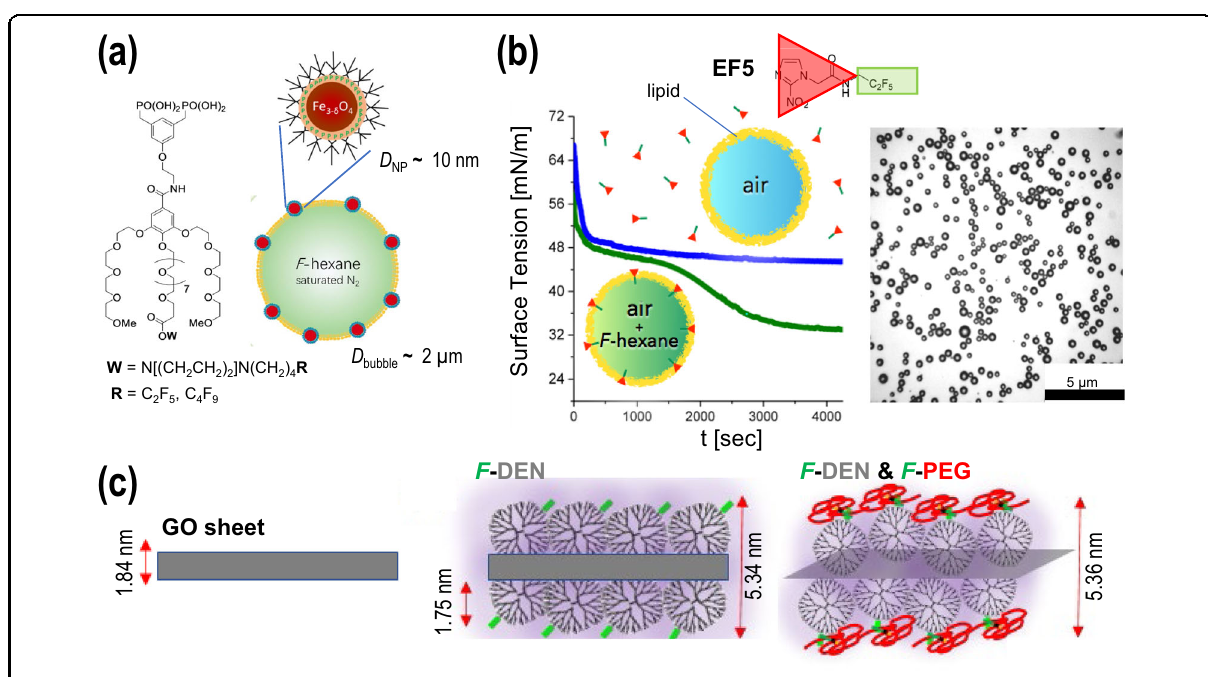
Fig. 6 Hierarchically organized fl uorinated self-assemblies for biomedical applications. a Fluorocarbon-stabilized microbubbles coated with phospholipids and dendronized iron oxide nanoparticles for bimodal ultrasound/MRI imaging diagnostics. Adapted from ref. 73 . b Left: the fl uorocarbon saturating the inner gas content of the microbubble enables adsorption of the fl uorinated hypoxia biomarker EF5 in a monolayer of phospholipids. Right: Optical microscopy image of an aqueous dispersion of EF5-containing microbubbles. Adapted from ref. 76 . c Schematic representation of the functionalization of a graphene oxide (GO) sheet by a layer of fl uorinated dendrimers ( F -DEN) on which a layer of fl uorinated PEG ( F -PEG) is adsorbed. These nanocomposites have proven ef fi cacy as O 2 reservoirs for reactive oxygen species production to kill bacteria and perform photodynamic therapy. Adapted from ref. 87